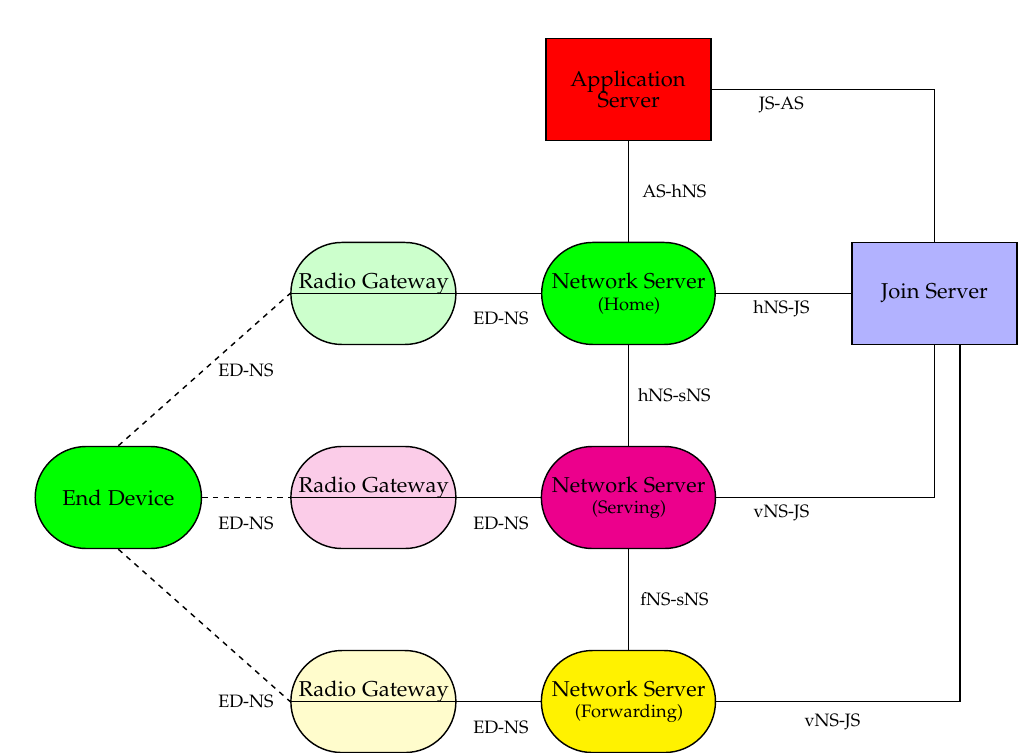
Figure 2. The architecture of the LoRaWAN TM system.